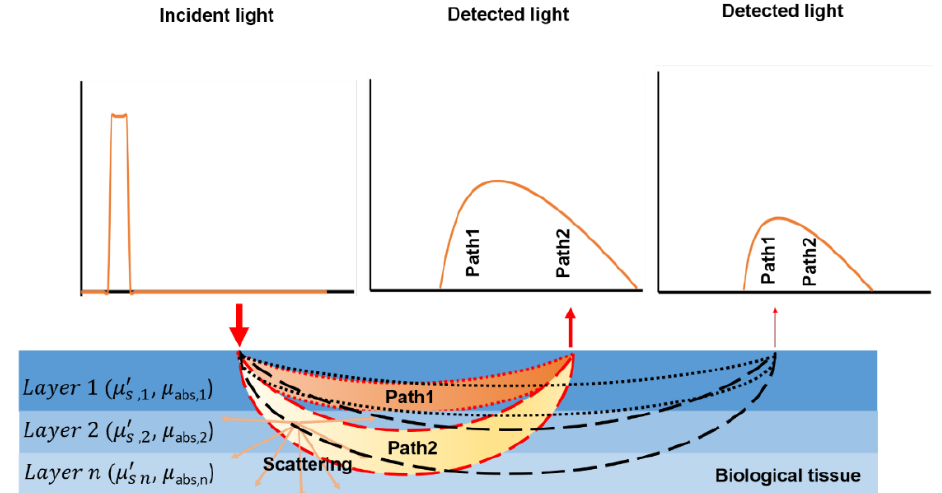
Figure 15. Mechanism of TD NIRS showing the incident light short pulse and two detected signals successively along with the possible photon paths “banana shape” in different layers with various absorption coefficient and reduced scattering coefficient.